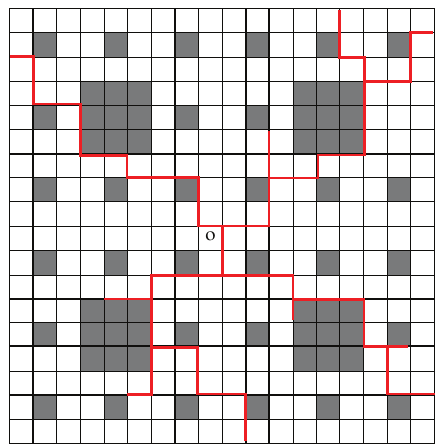
Figure 1: Lattice percolation on lattice Sierpinski